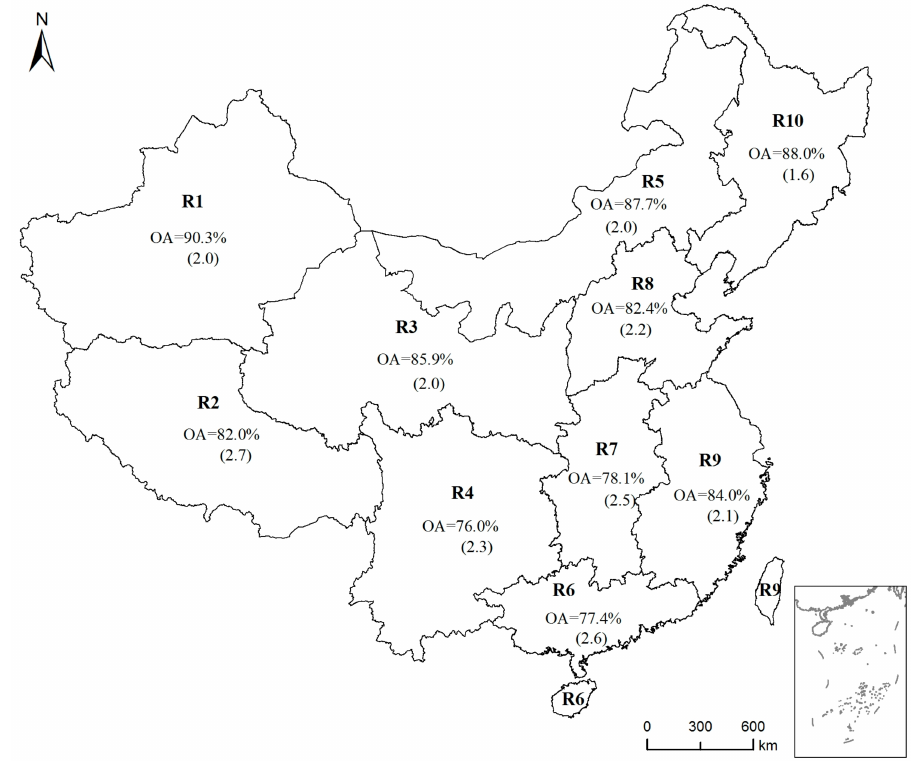
Figure 2. Regional overall accuracies for GlobeLand30 2010 over China based on the definition of agreement as a match between the map class and either the primary or alternate reference class. Standard errors for the overall accuracies are in